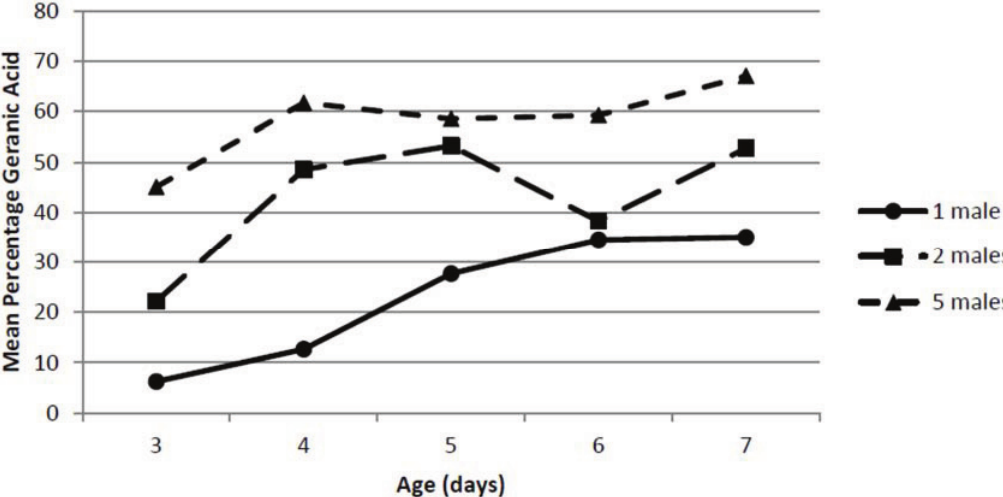
Figure 4. Effect of male density and age on percentage geranic